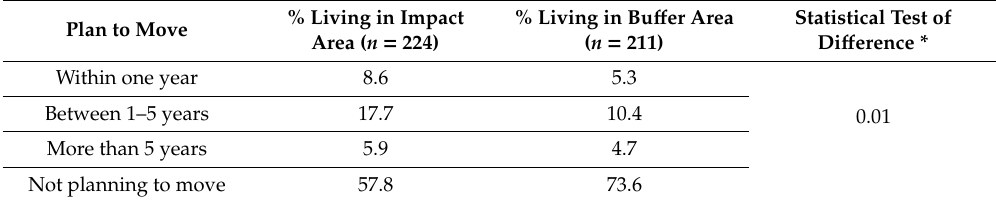
* p -value corresponds to test of independent proportions—Chi-square test.